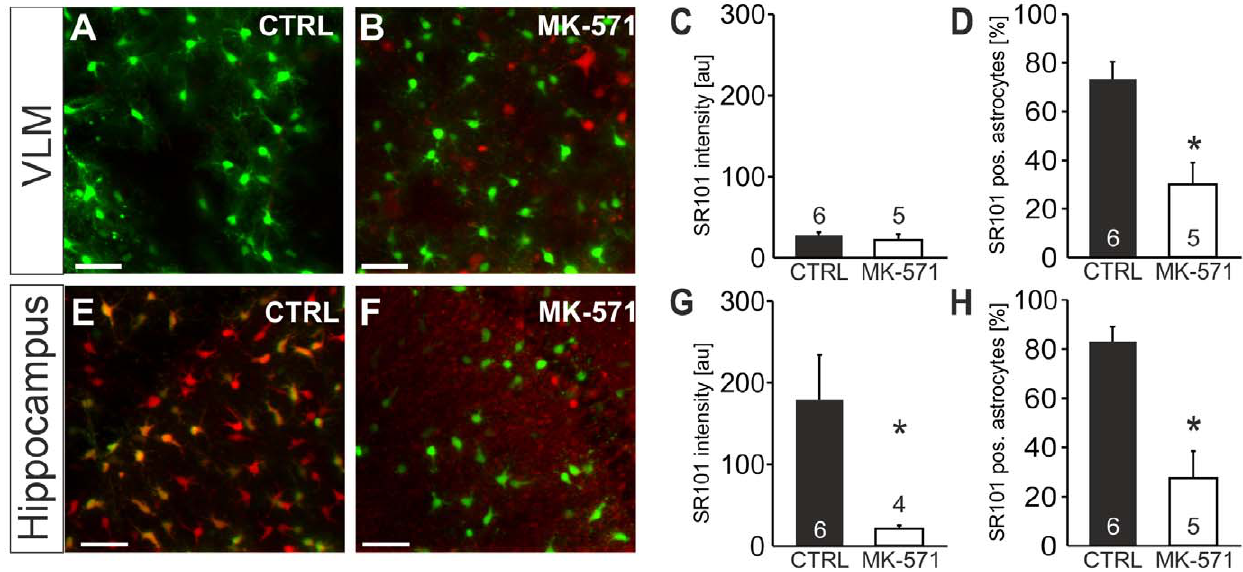
Figure 7. Test for the contribution of MRP-transporters to selective SR101-labeling. A–H: Effect of Mrp1-blocker MK-571 on SR101- labeling in the VLM ( A–D ) and hippocampus ( E–H ) using EGFP-expressing astrocytes. A: Overlay of EGFP- and SR101-fluorescence in the VLM after staining in CTRL conditions. B: Overlay of EGFP- and SR101-fluorescence after staining with MK-571 (200 m M) in the staining solution. C, D: Statistical comparison shows no change of SR101-fluorescence intensity of EGFP-positive astrocytes in the VLM ( C ) but a reduction of the fraction of EGFP- positive astrocytes that were also labeled with SR101. E: Overlay of EGFP- and SR101-fluorescence in the hippocampus after staining in CTRL conditions. F: Overlay of EGFP- and SR101-fluorescence after staining with MK-571 (200 m M) in the staining solution. G, H: Statistical comparison reveals that the intensity of SR101-labeling as well as the fraction of EGFP-positive astrocytes that were also labeled with SR101 was significantly reduced by MK-571 present during staining.